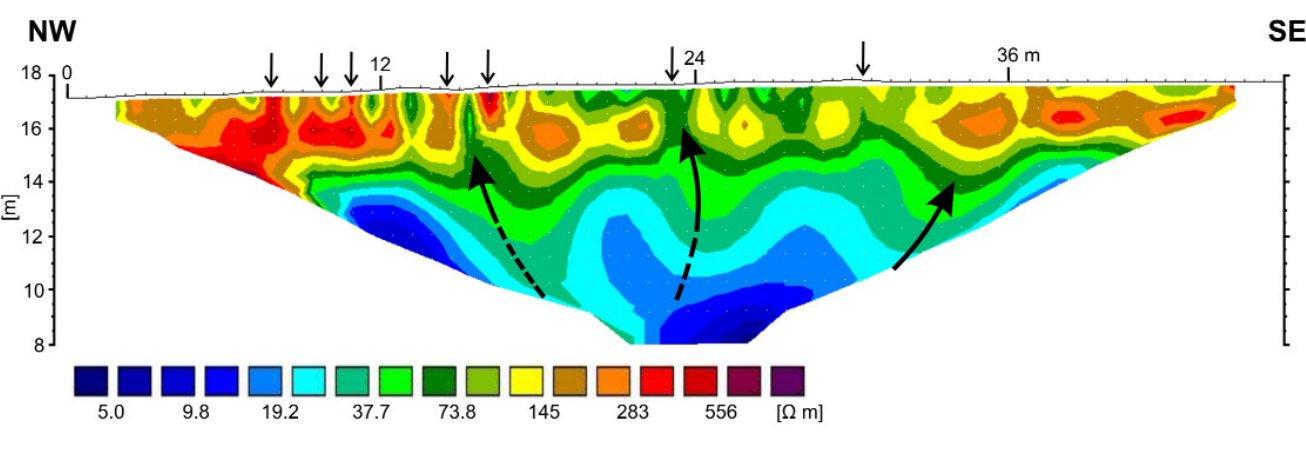
Figure 3. Two-dimensional resistivity model conducted at site 2 in San Carlo. The small arrows at the top of the profile indicate the positions of the ground ruptures, while the larger arrows suggest the mobilisation pathways of the liquefied material in the